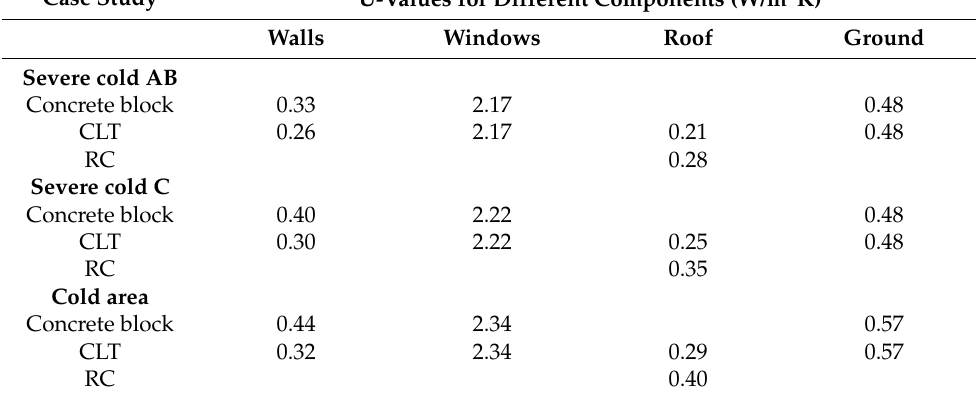
Table 6. Envelope U-values.